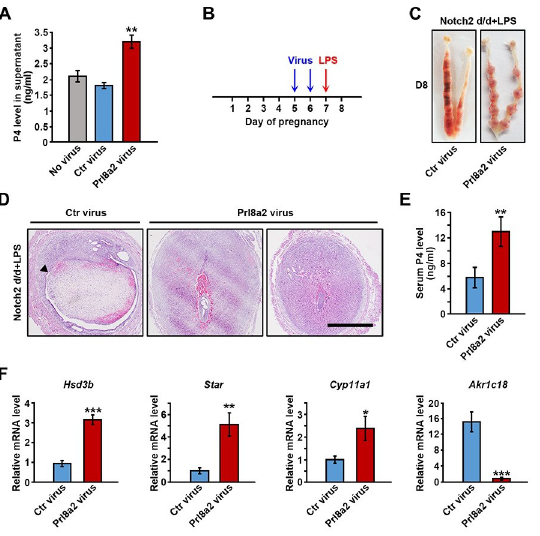
Fig 5. Prl8a2 overexpression rescued pregnancy failure in LPS-treated Notch2 d/d mice. (A) Lentivirus-mediated Prl8a2 overexpression prompted P4 secretion by cultured CL cells. (B) Virus injection and LPS treatment was carried out as illustrated. (C) Overexpression of Prl8a2 in Notch2 d/d mice rescued LPS-induced pregnancy failure. (D) H&E staining revealed normal embryo development in most implantation sites of LPS-treated Notch2 d/d mice after Prl8a2 overexpression. Arrowhead indicates abortion-induced decidual shedding. Scale bar: 300 μ m. (E) The serum P4 level was compared in LPS-treated Notch2 d/d mice with or without Prl8a2 overexpression. (F) The relative mRNA level of genes related to P4 synthesis or degradation in ovaries of LPS-treated Notch2 d/d mice with or without Prl8a2 overexpression. Data in (A), (E) and (F) are presented as mean ± SEM. � p < 0.5, �� p < 0.01, ��� p < 0.001.